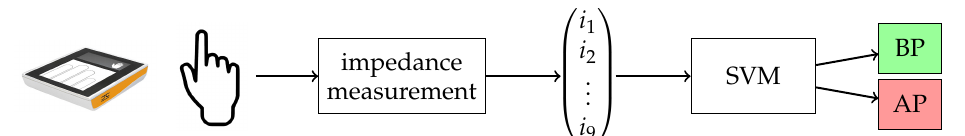
Figure 4. While capturing the fingerprint, the impedance is measured at nine selected frequencies.